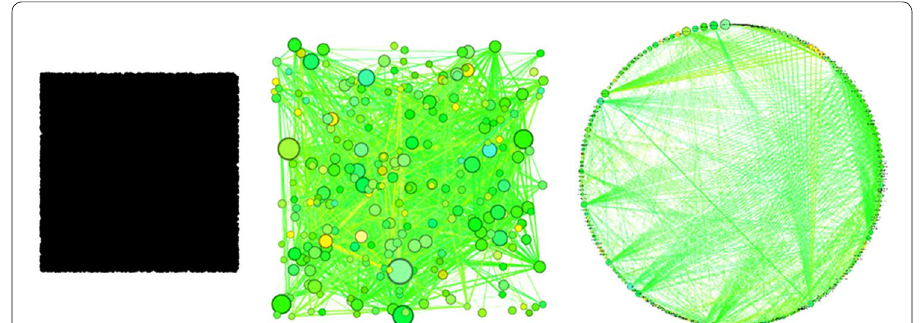
Fig. 2 From left to right: the first network is the initial visualization of network of co-inventors with no filtering; the second one is the network after applying steps 1 and 2; and the third network is after the applying the circular